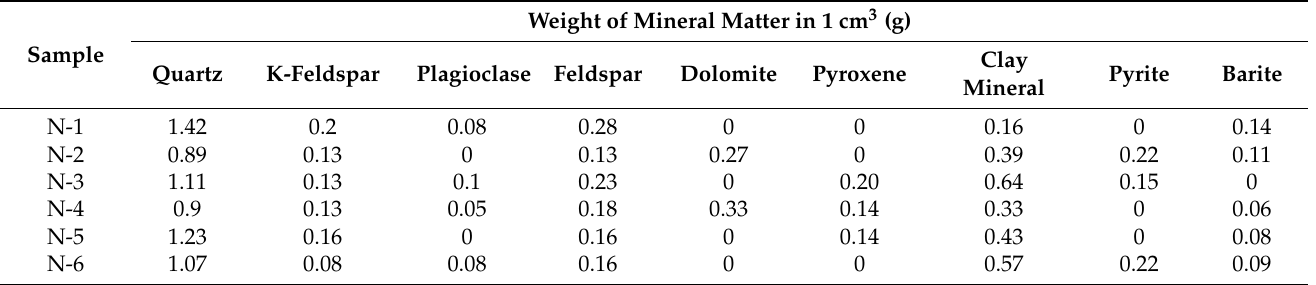
Table 4. Mineral weight calculated for a unit sample volume of 1 cm 3 (see descriptions in the